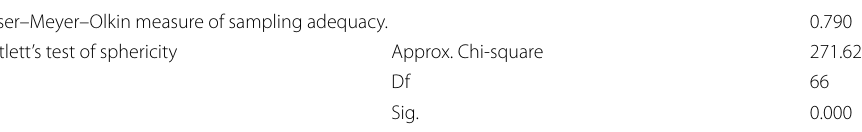
Table 7 KMO and Bartlett’s test (Post-DeMo, Anand) Kaiser–Meyer–Olkin measure of sampling adequacy.